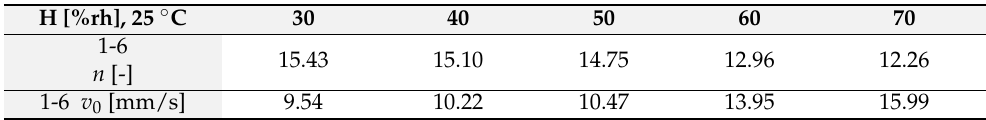
Table 1. Crack growth parameters as a function of humidity, cf. [11].